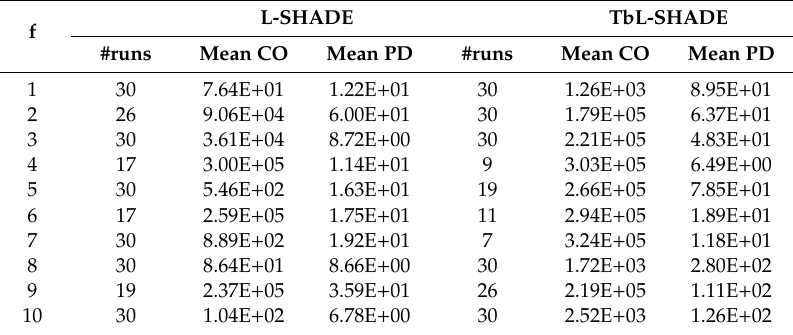
Table 30. Clustering and population diversity of L-SHADE and TbL-SHADE on the CEC2020 in 20 D